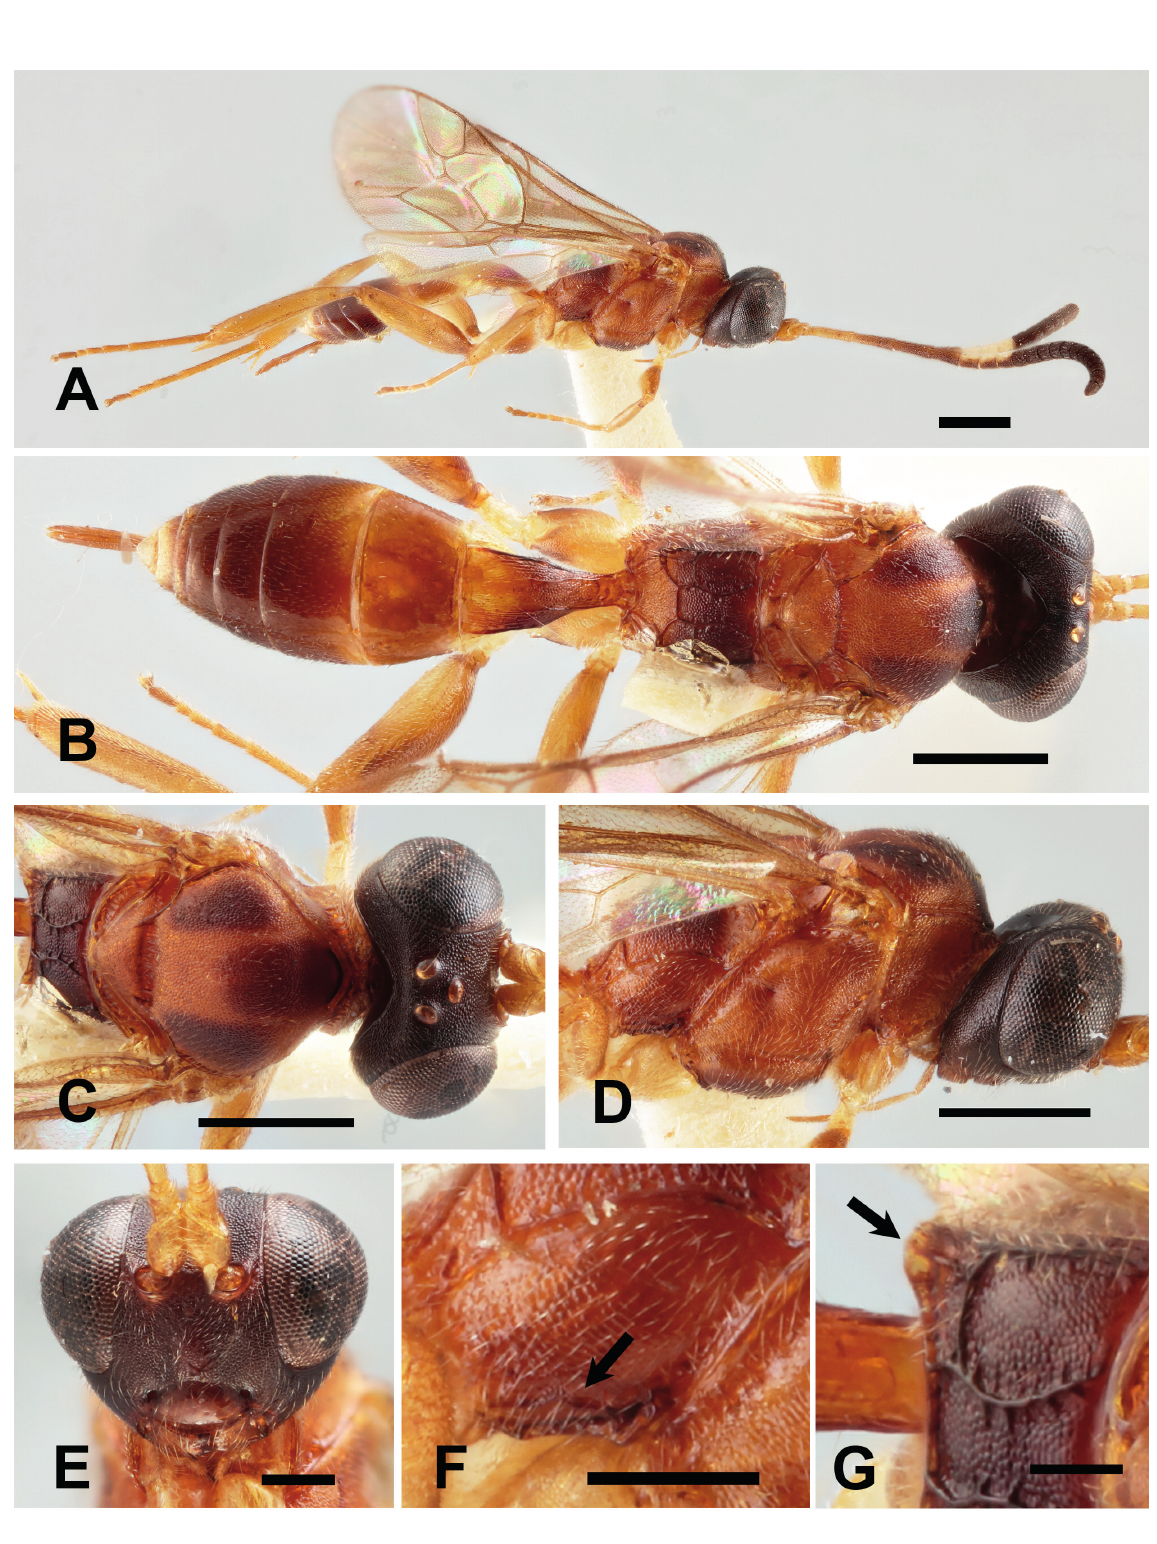
Fig. 3. Morphology of Handaoia fritzi sp. nov., holotype, ♀ (NHMUK010636396). A . Habitus, lateral view. B . Habitus, dorsal view. C . Head and mesoscutum, dorsal view. D . Head and mesosoma, lateral view. E . Head, front view. F . Metapleuron (arrow: juxtacoxal carina). G . Propodeum (arrow: propodeal apophysis). Scale bars: A–D = 0.5 mm; E–F = 0.2 mm; G = 0.1